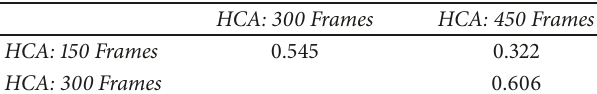
Table 4: Pairwise cluster